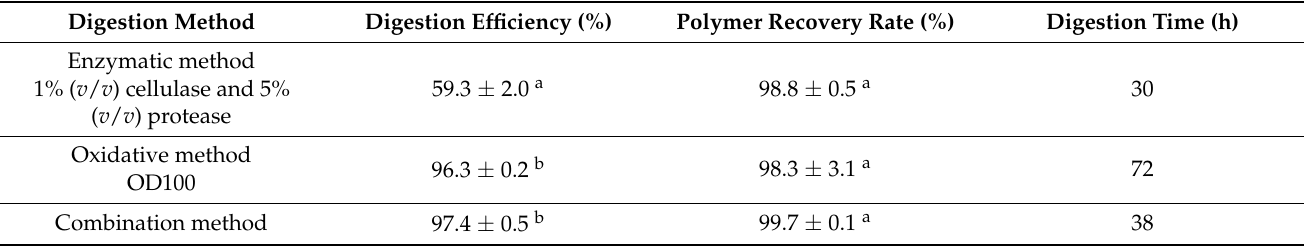
Table 3. The comparison of digestion efficiency, polymer recovery rate, and digestion time for the optimized enzymatic-, oxidative-, and combination